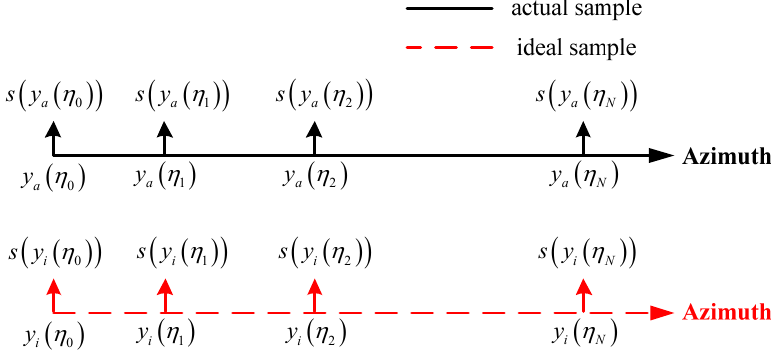
Figure 2. Sample geometry after the initial motion compensation.